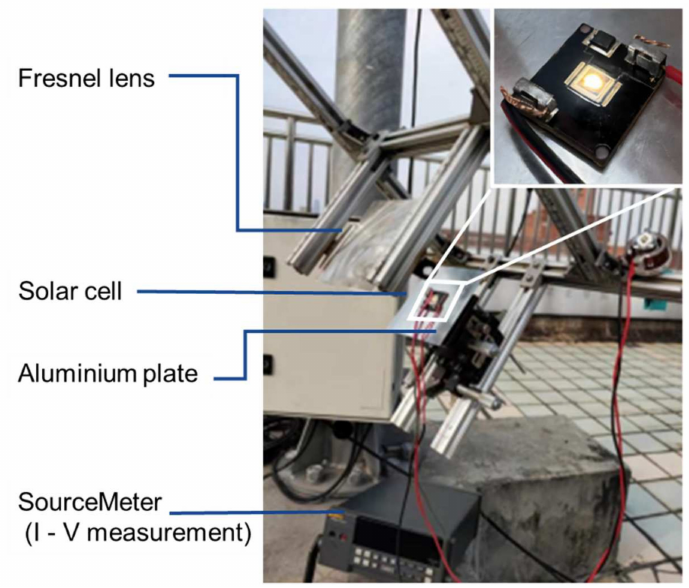
Figure 12. Outdoor performance test of the triple-junction solar cell. The insect shows the solar cell with the focusing spot irradiated on the surface.